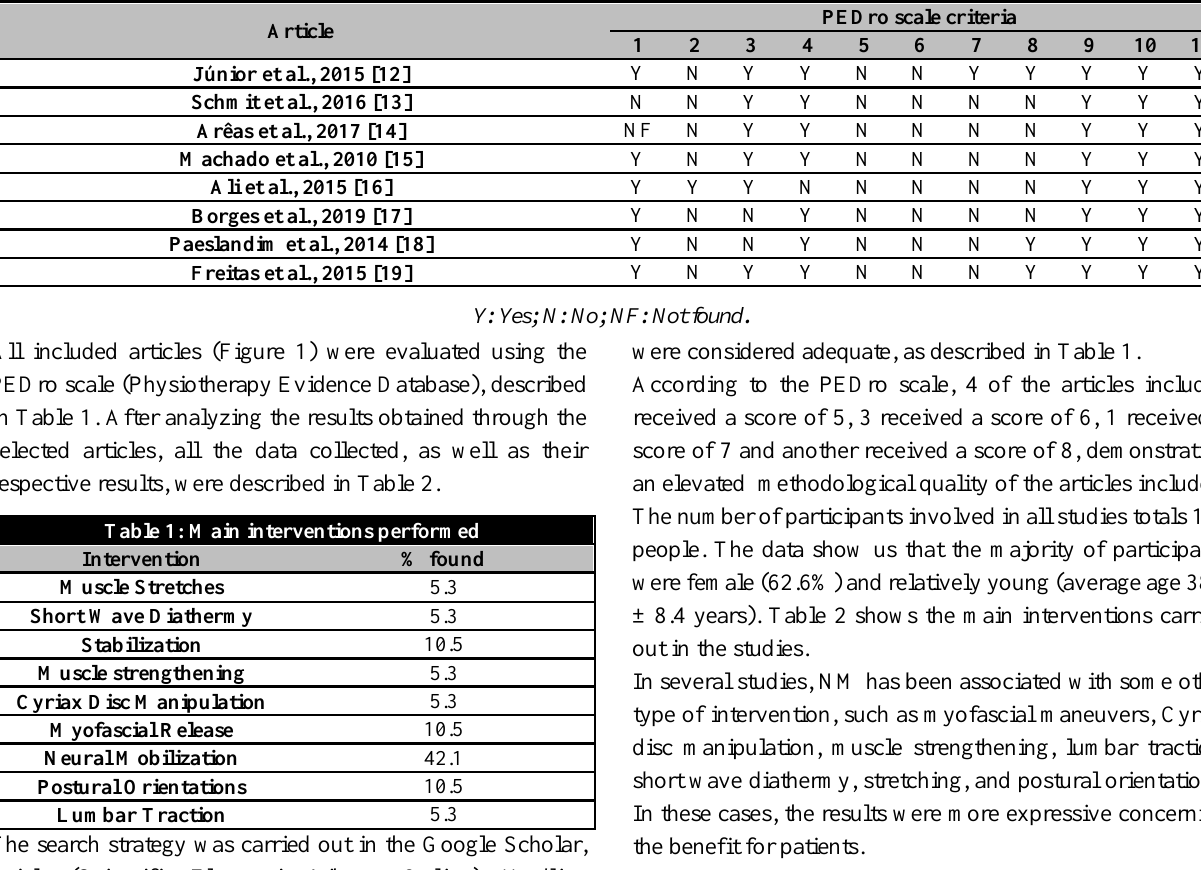
Table 1: Evaluation of potential articles based on the PEDro scale.